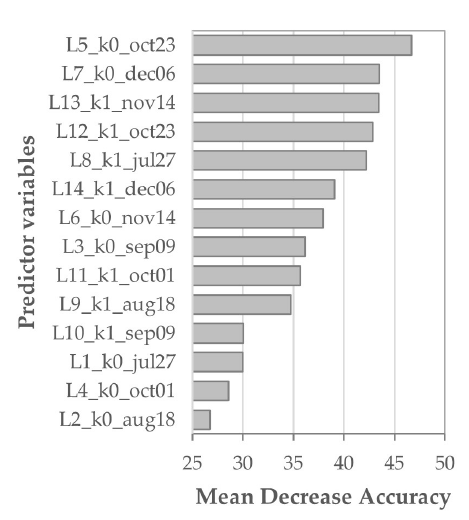
Figure 8. Variable importance plot of the Random Forest classifier with the predictor variables from the Kennaugh element, KE C1, and classification scheme ranked by Mean Decrease Accuracy (MDA). See Table 4 for the layer naming convention of the predictor variables and Table S3 for the predictor ranking for the individual land cover